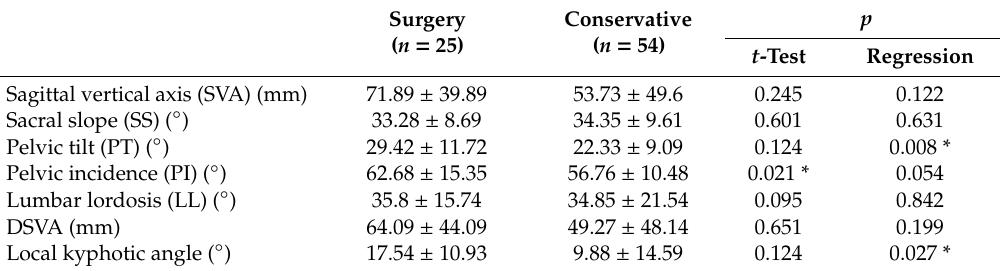
Table 2. Comparison of spinopelvic parameters and univariate